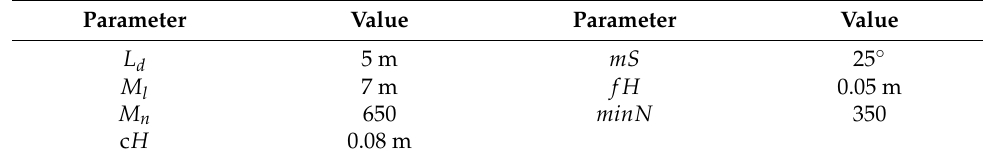
Table 2. Parameter table for the extraction of road